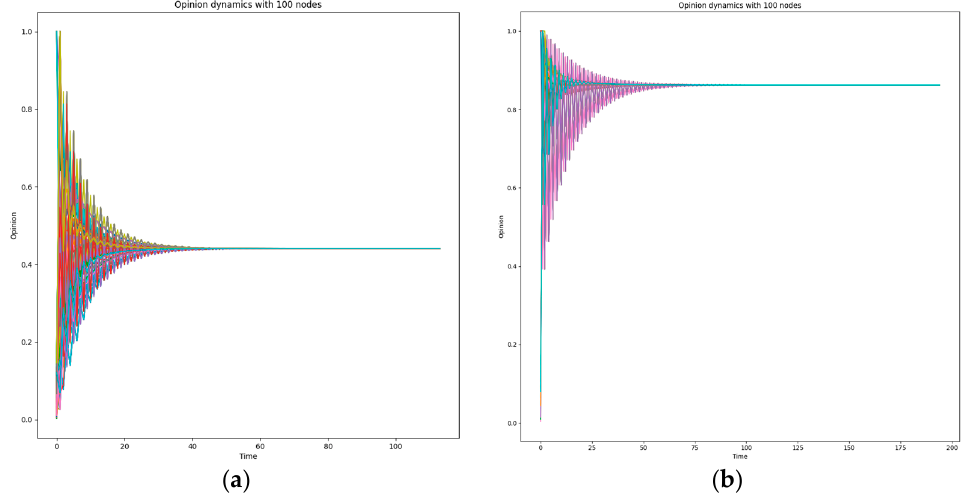
Figure 3. ( a ) 10 out of 100 nodes are infected. ( b ) 55 out of 100 nodes are infected.